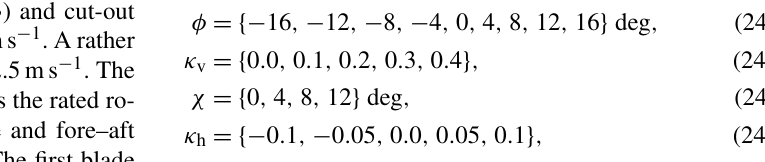
Rev cosine (a) and sine (b) out-of-plane moment components are shown for different wind state ×